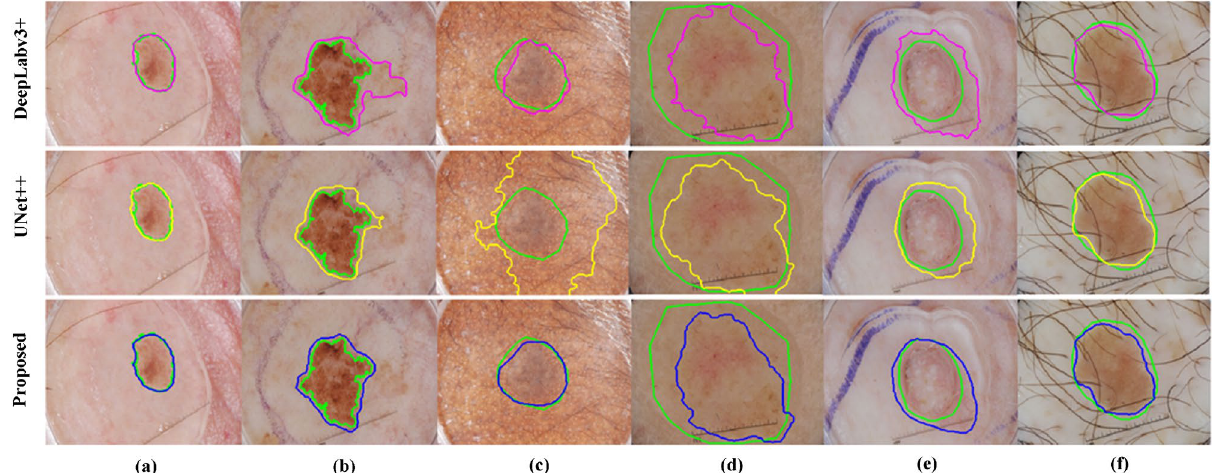
Figure 5. Examples of the segmented skin lesions via the proposed CMM-Net (blue contours) against the ground-truth annotations (green contours). ( a )–( c ) Represent precise segmentation results, ( d ) and ( e ) refer to under-fitting and over-fitting segmented samples, respectively, and (f) indicates accurate boundary segmentation result with the presence of the hair artifact. The segmentation results of DeepLabv3 + (magenta contours) and UNet + + (yellow contours) are presented in first and second rows,